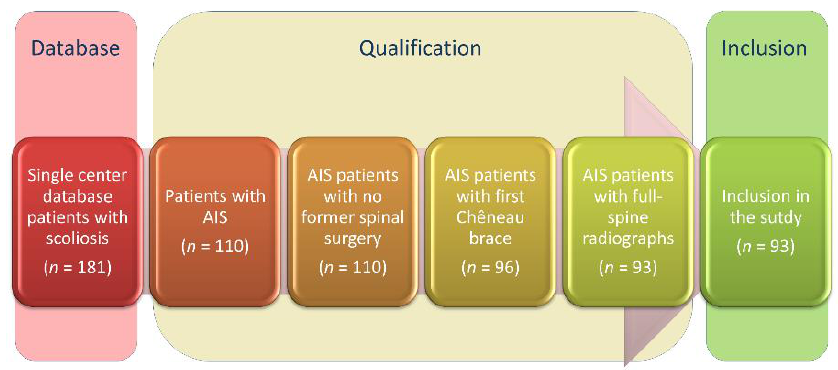
Figure 1. Flow diagram describing the inclusion process of the study